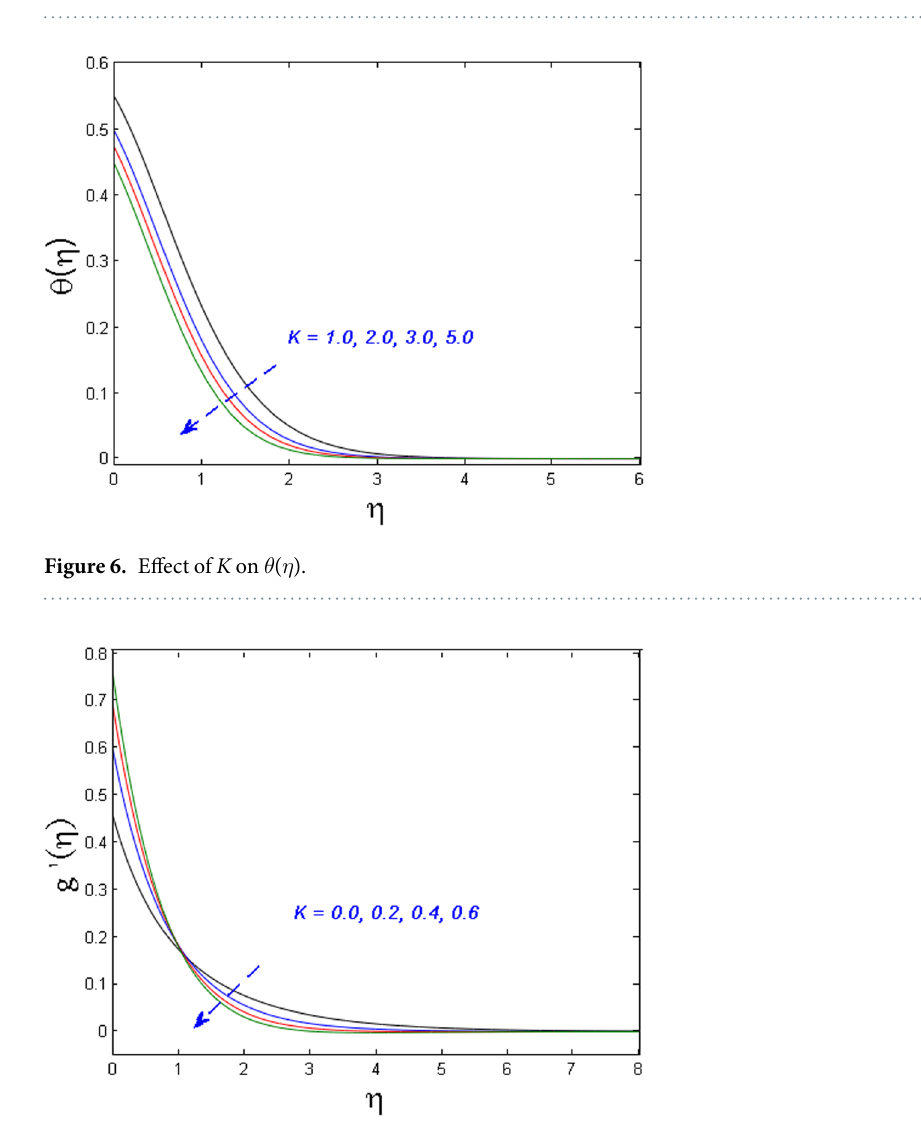
Figure 5. Effect of K on f ′ ( η ).